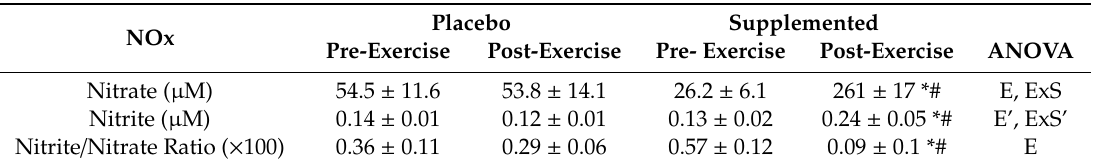
Table 3. E ff ects of an exercise test and acute sodium nitrate supplementation on plasma nitrite and nitrate concentrations. Placebo Supplemented NOx Pre-Exercise Post-Exercise Pre- Exercise Post-Exercise ANOVA Nitrate ( µ M) 54.5 ± 11.6 53.8 ± 14.1 Nitrite ( µ